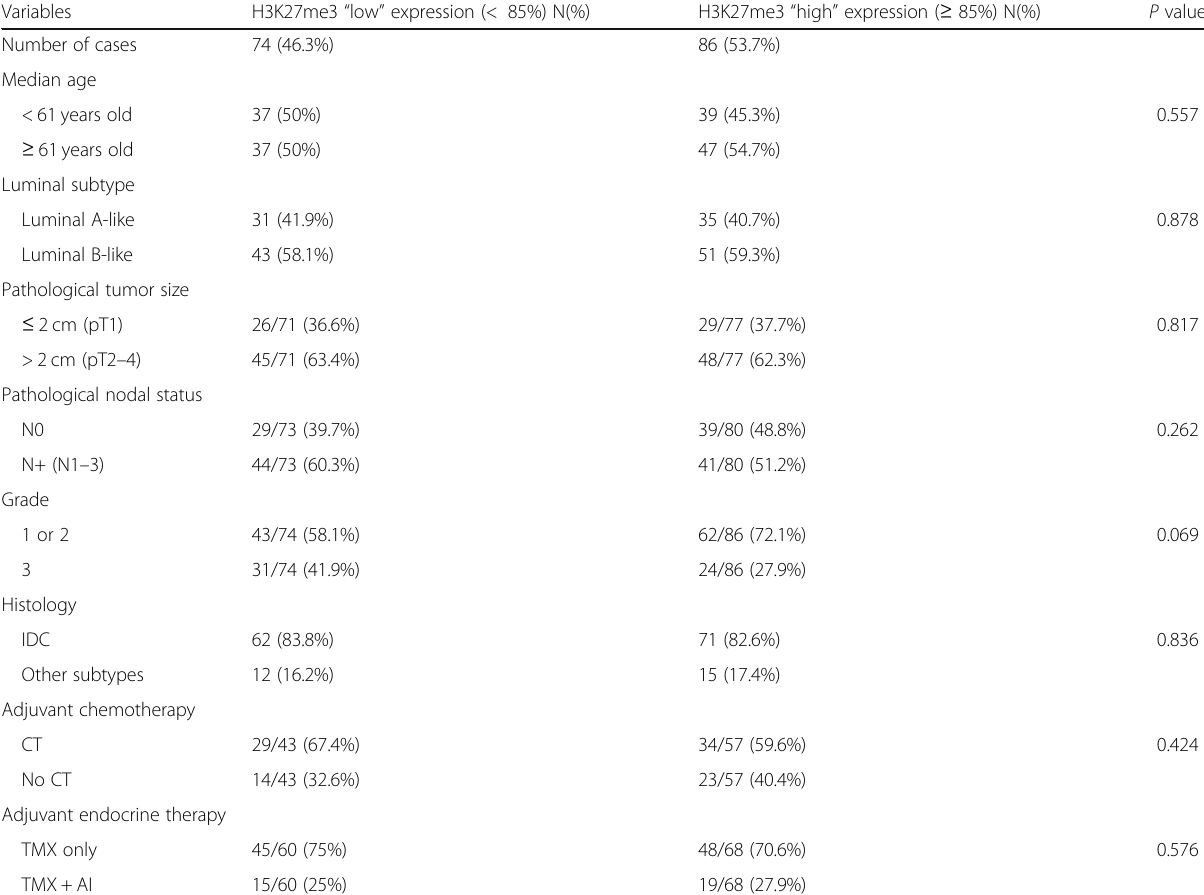
Table 3 Association of H3K27me3 expression (85% cut-off) with clinicopathological features Variables